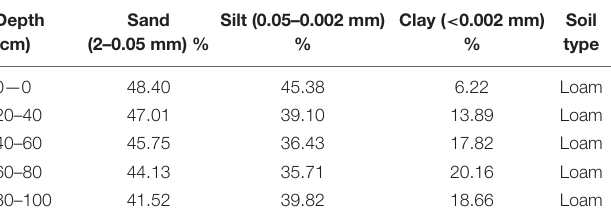
TABLE 4 | Soil textural classes in the soil profile 0–100 cm (according to IEDA laboratory results). Depth